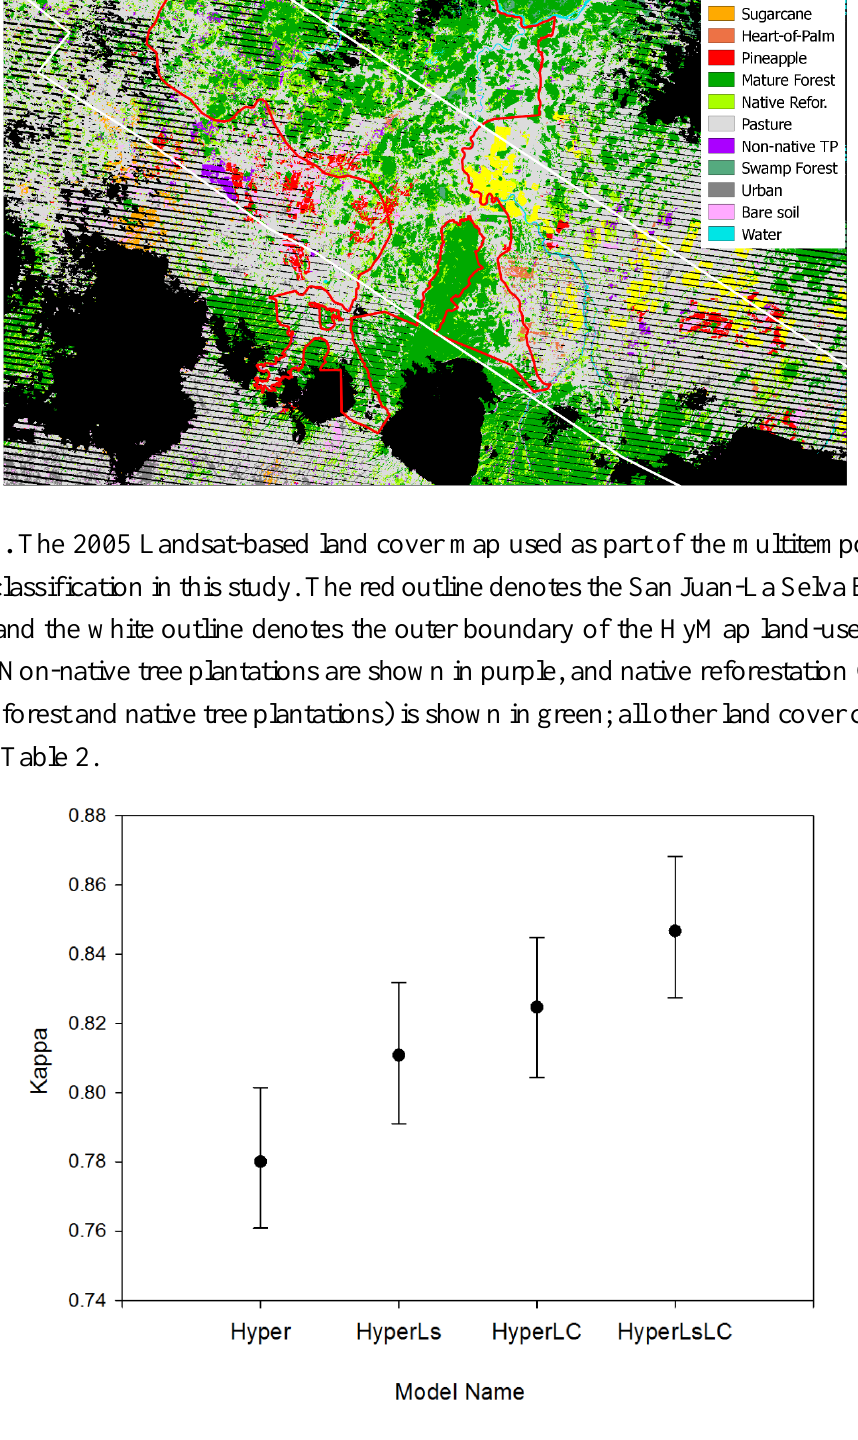
Figure A2. Kappa values of the four different RF models (mean ±95% CI) with four summary classes. All Kappa values differ significantly between models ( p <